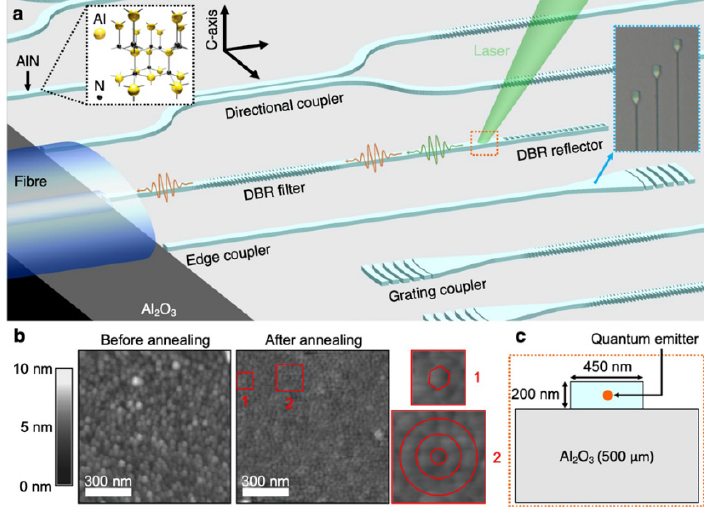
Figure 16. Quantum emitters in aluminum nitride integrated photonics. ( a ) Scalable AlN-on-sapphire photonic integrated circuits with integrated quantum emitters. Black inset: Wurtzite crystal structure of aluminum nitride (yellow: aluminum atom, black: nitrogen atom). Blue inset: Microscope